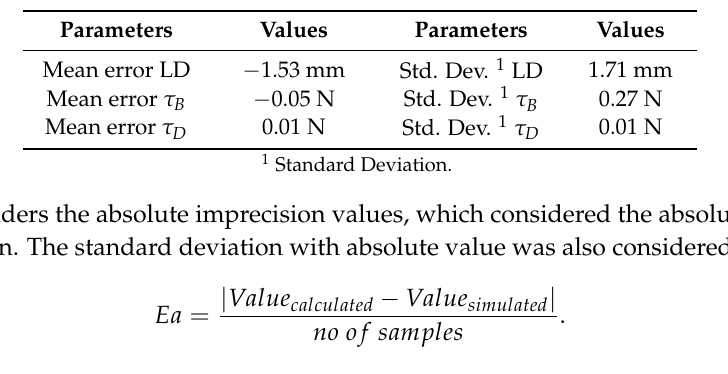
Table 4. Absolute error between the model and simulation.